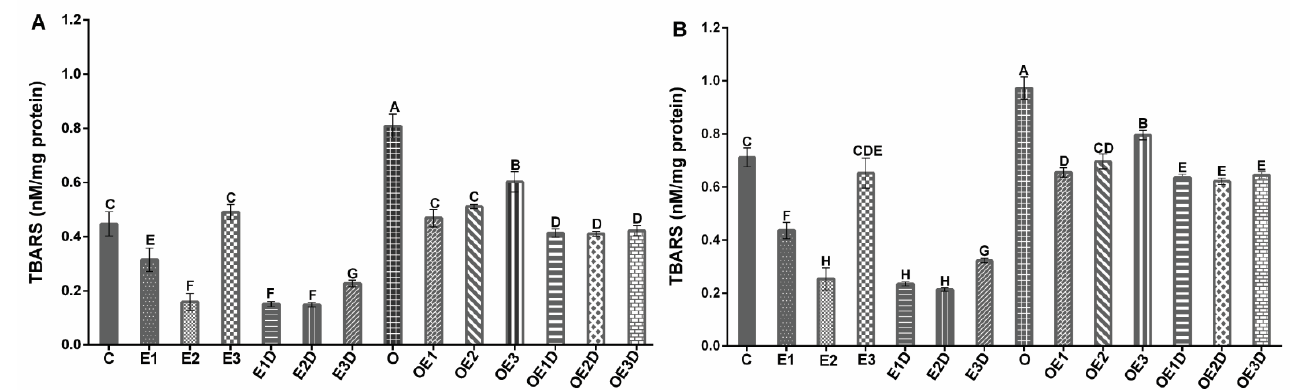
Figure 2. Effect of different exercise intensities and diazoxide on ROS of skeletal muscle in obese rats. ( A ) Soleus muscle ( B ) EDL muscle. C: control; D: diazoxide; E1: low-intensity exercise; E2: mod- erate-intensity exercise; E3: high-intensity exercise; E1D: low-intensity diazoxide exercise; E2D: ex-